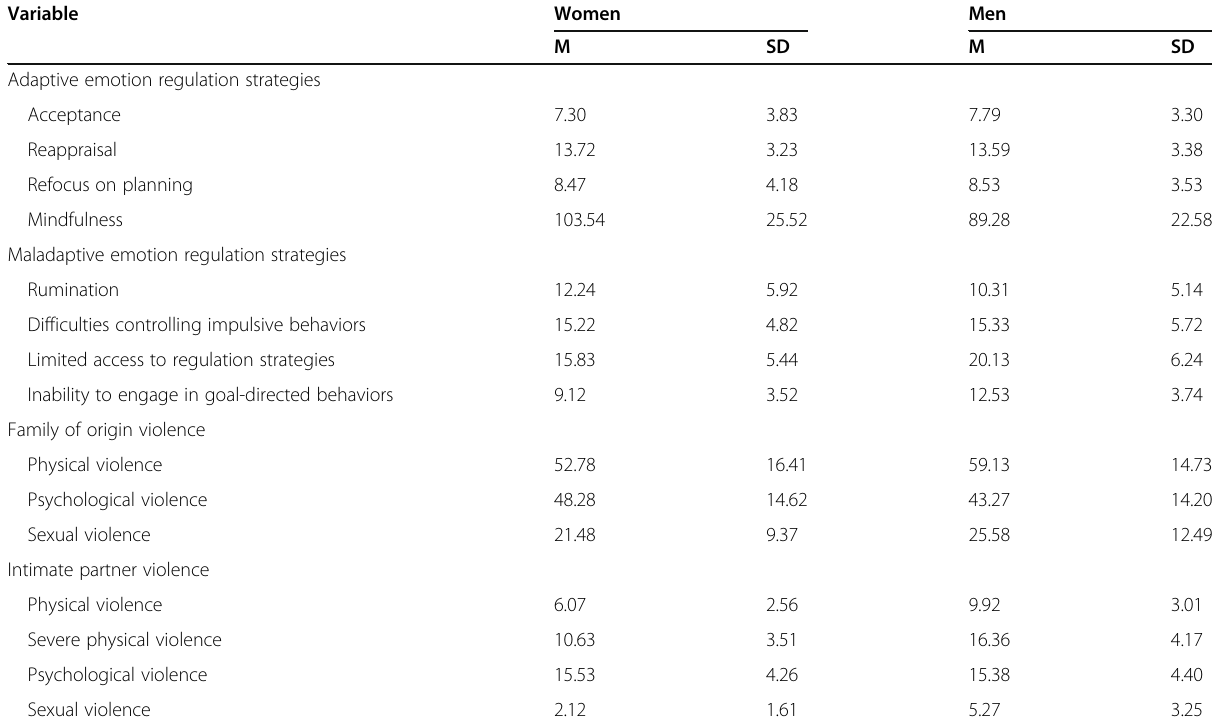
Table 1 Means and standard deviations of study variables by sex Variable Women Adaptive emotion regulation strategies